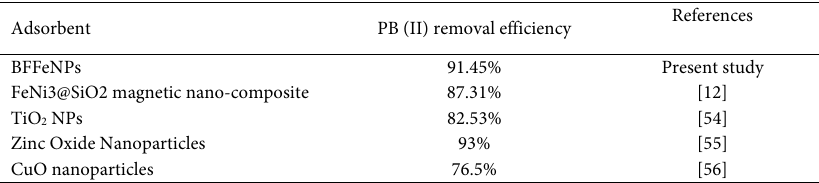
Table 5. The comparison of Pb (II) removal efficiency for different